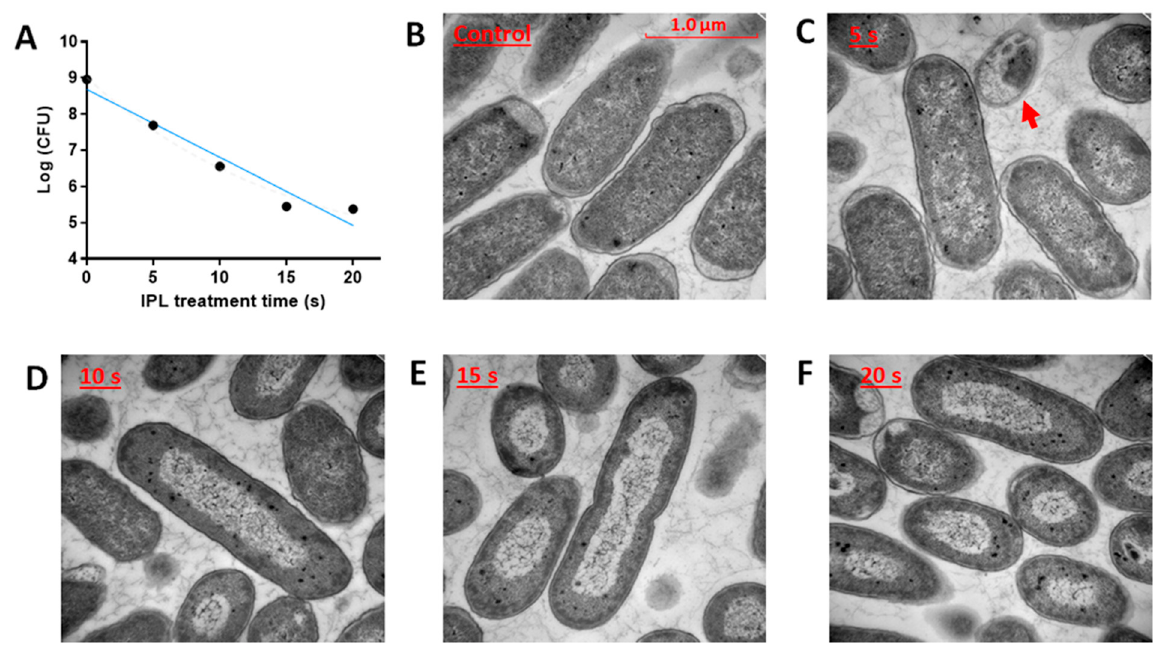
Figure 1. Effects of IPL on E. coli growth and morphology. ( A ) Plate counts of E. coli after the IPL treatments. The linear regression between Log-transformed CFU and the IPL treatment time ( t ) yielded an equation of Log(CFU) = − 0.1882 t + 8.688 with r 2 = 0.94. The control and IPL-treated E. coli cells were examined by TEM imaging: ( B ) control; ( C ) 5 s (a dead cell is marked by the red arrow); ( D ) 10 s; ( E ) 15 s; and ( F ) 20 s. Scale bars = 1.0 µ